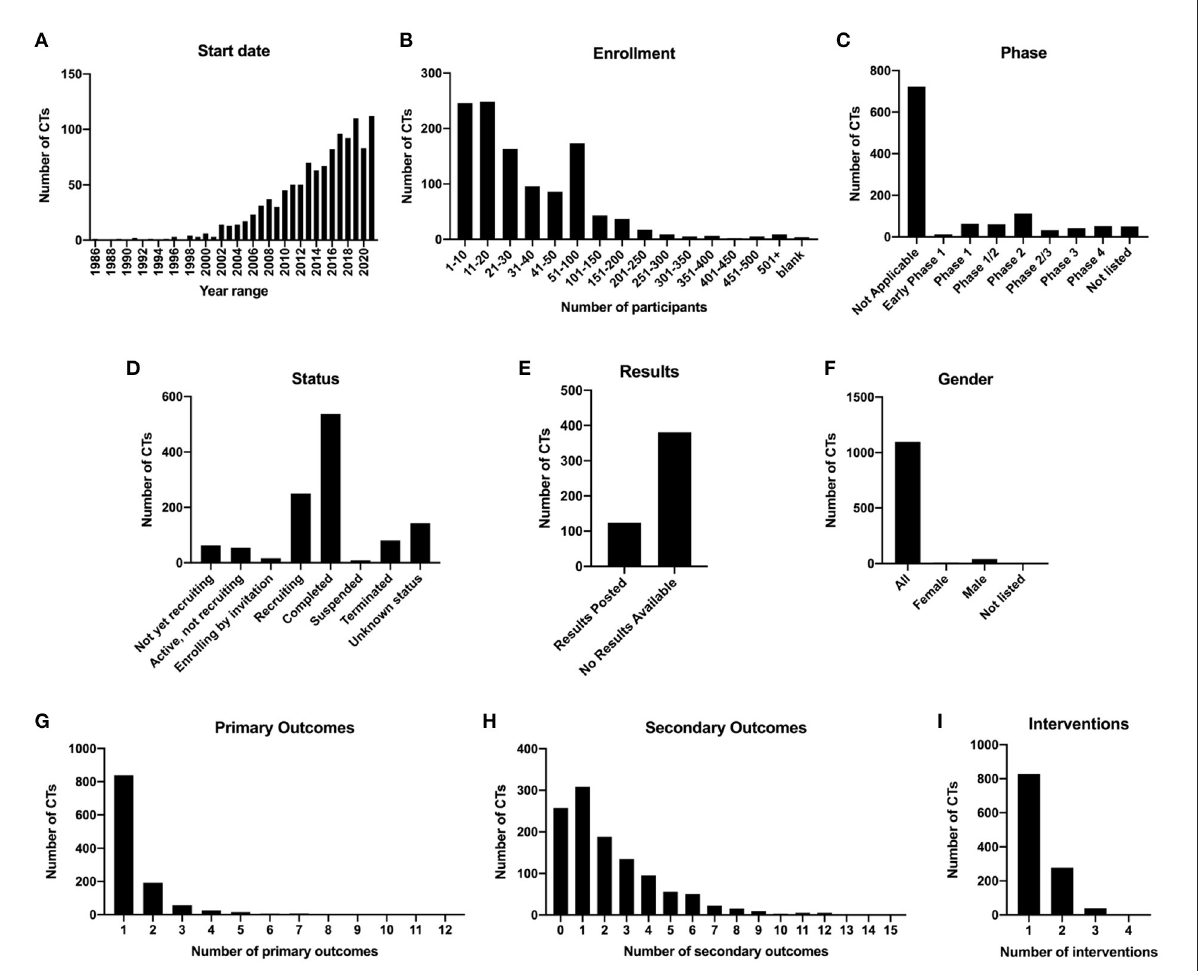
FIGURE2 Demographics and statistics for 1,149 spinal cord injury clinical trials. (A) Numbers of clinical trials initiated per year from 1986 to 2021. (B) Number of clinical trials binned by actual or estimated enrollment of patients. (C) Number of clinical trials in each phase category. (D) Number of clinical trials in each status category. (E) Clinical trials marked as Completed and at least 1 year past the completion date, with results posted or no results available. (F) Number of clinical trials according to gender of enrolled subjects. (G) Number of clinical trials with 1, 2, 3, or 4 interventions. (H) Number of clinical trials with one or more types of primary outcome. (I) Number of clinical trials with one or more types of secondary outcome.